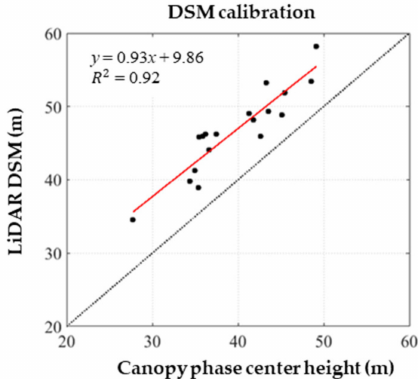
Figure 6. Correlation analysis between the LiDAR DSM and the canopy phase center height estimated by the SKP-IMLE